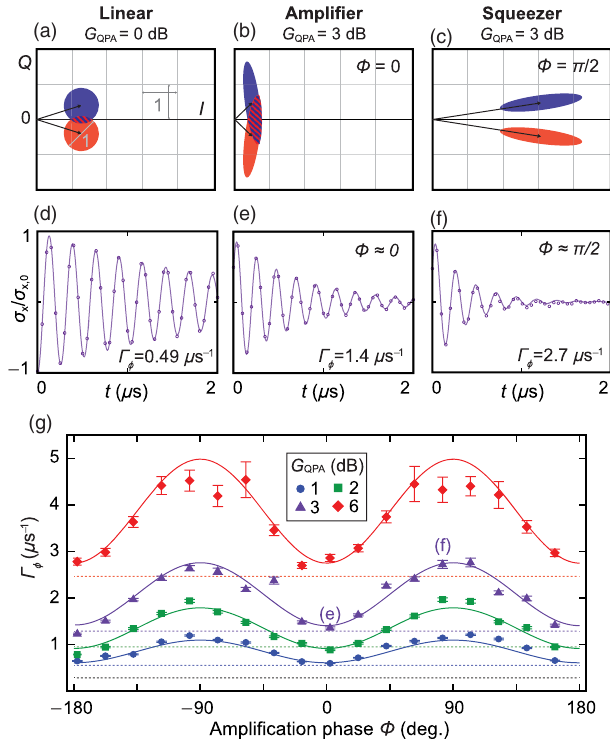
FIG. 3. (a) – (c) Approximate QPA output fields, calculated as in Fig. 2. (a) With no flux pump applied, a measurement tone reflected from the QPA acquires a ˆ σ -dependent phase rotation. z (b) Applying a flux pump with phase Φ ¼ 0 amplifies the noise in the signal quadrature Q , reducing the output SNR but increasing robustness to off-chip losses. (c) The orthogonal choice Φ ¼ π = 2 produces the opposite effects. The mean signal size is amplified slightly for either choice of Φ . (d) – (f) Ramsey experiments corresponding to the drive conditions used to calculate (a) – (c), exhibiting dephasing induced by a measurement tone applied during the Ramsey free evolution with (d) no on-chip gain, (e) amplifier-mode gain ( Φ ¼ 0 ), or (f) squeezer-mode gain ( Φ ¼ π = 2 ). (g) Points indicate inferred Γ ϕ values for a fixed measurement power ( − 142 dBm) over a range of pump settings. G Colored dashed lines indicate Γ ϕ ; the black dashed ; parasitic ð QPA Þ line indicates 1 =T (cid:3) 2 . Solid curves are a single fit to Eq. (4), where the only free parameter is a global phase. Dephasing is slowest (fastest) in the amplifier (squeezer) mode, where the SNR at the QPA output is lowest (greatest). We attribute the discrepancy at high gain and Φ ≈ (cid:4) π = 2 to higher-order nonlinearities driven by the large photon number at this